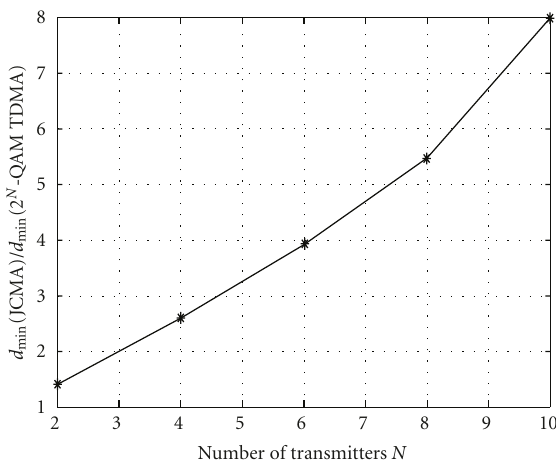
Figure 3: Performance gain buildup using random symbol